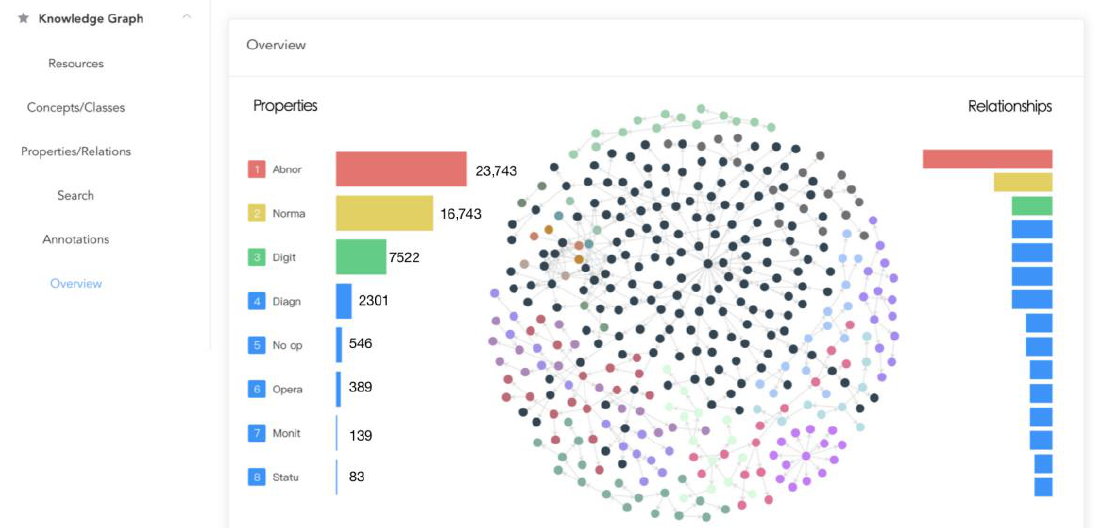
Figure 7. Knowledge Graph Overview.